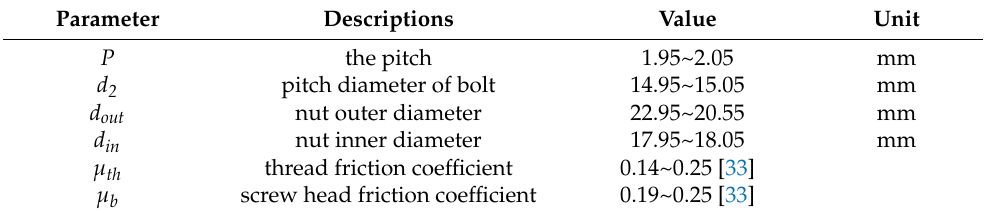
Table 1. Bolt geometrical parameters.